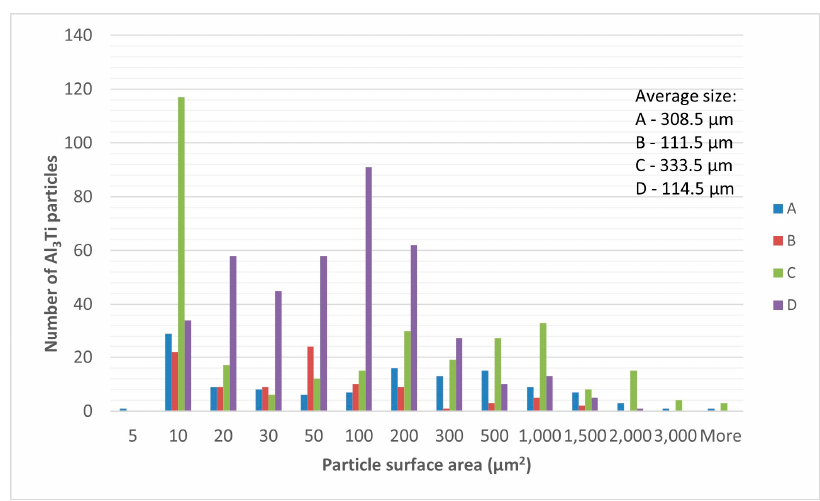
Figure 6. Al 3 Ti particle size distribution in various grain re fi ners.